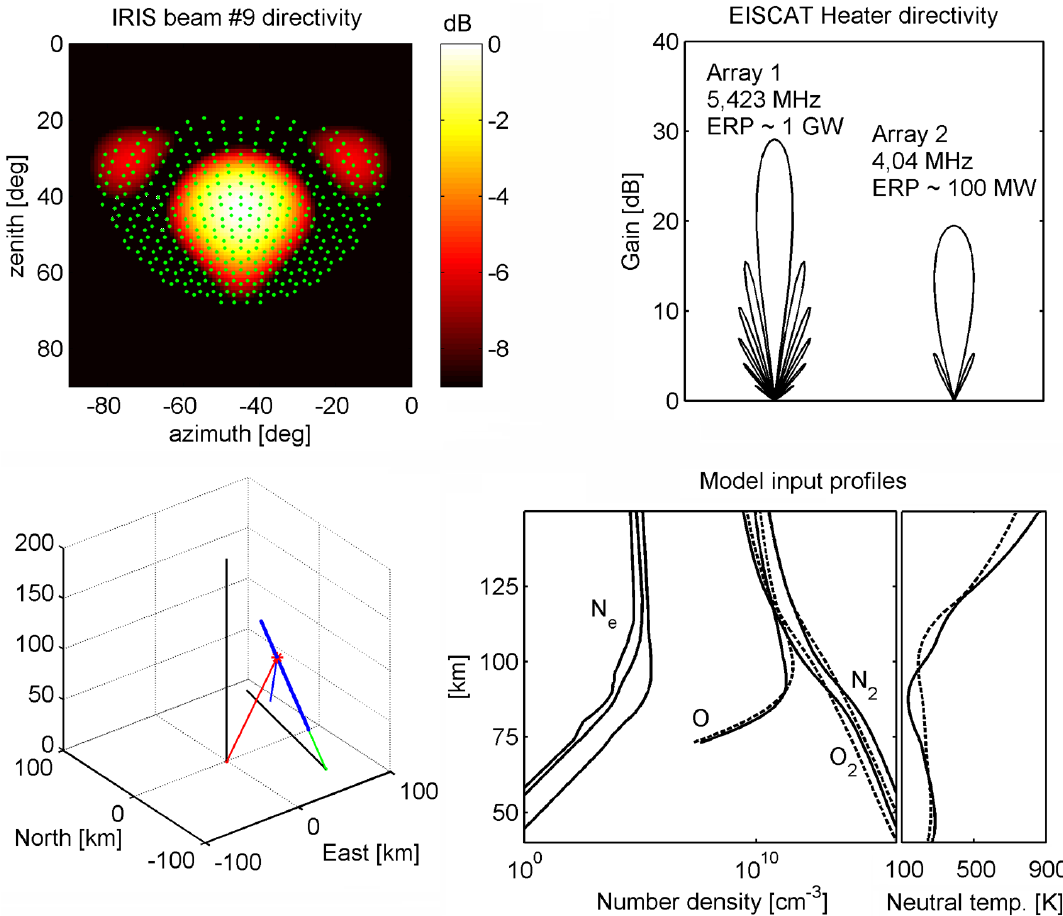
Fig. 2. Upper left panel: Beam directivity of Kilpisjärvi IRIS beam 9 and the 401 ray paths used in modelling the absorption (found using triangular tesselation with equally spaced barycentres). Upper right panel: Antenna beam directivities for antenna fields 1 and 2 of the Eiscat heater. Lower left panel: Ray paths used in the modelling of the heater effect. Black lines are centre lines of heater beam and IRIS beam 9. The green line shows one of the 401 barycentre directions along which the model is run in 1-km steps (blue points). The red line is the heater line-of-sight direction for one of these model points. Lower right panel: Profiles of electron density (Friedrich et al., 2004), atmospheric neutral components and temperature (MSISE-90) for the modelling